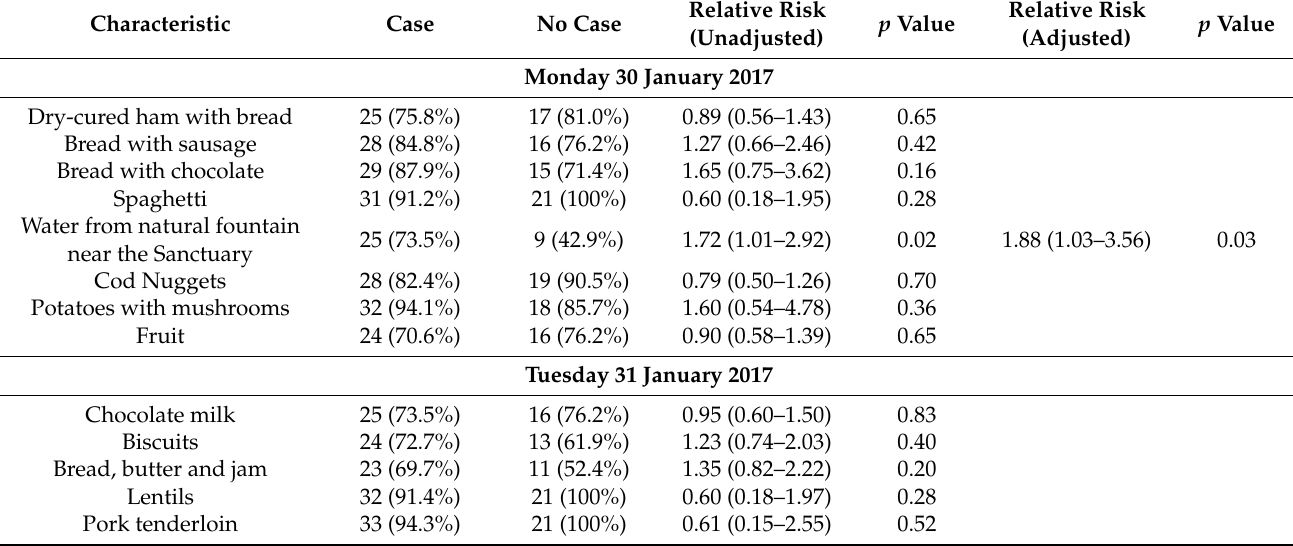
Table 1. Univariate and multivariate analyses of risk factors (food and beverages) for being a case.